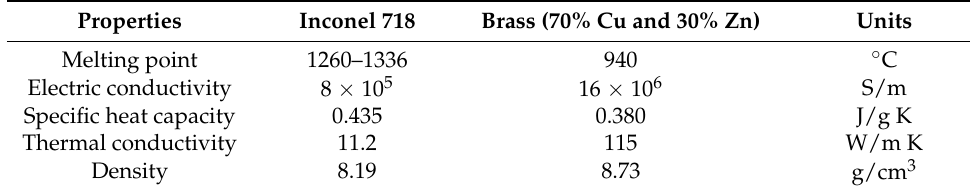
Table 1. Physical properties of workpiece and wire electrode [30].